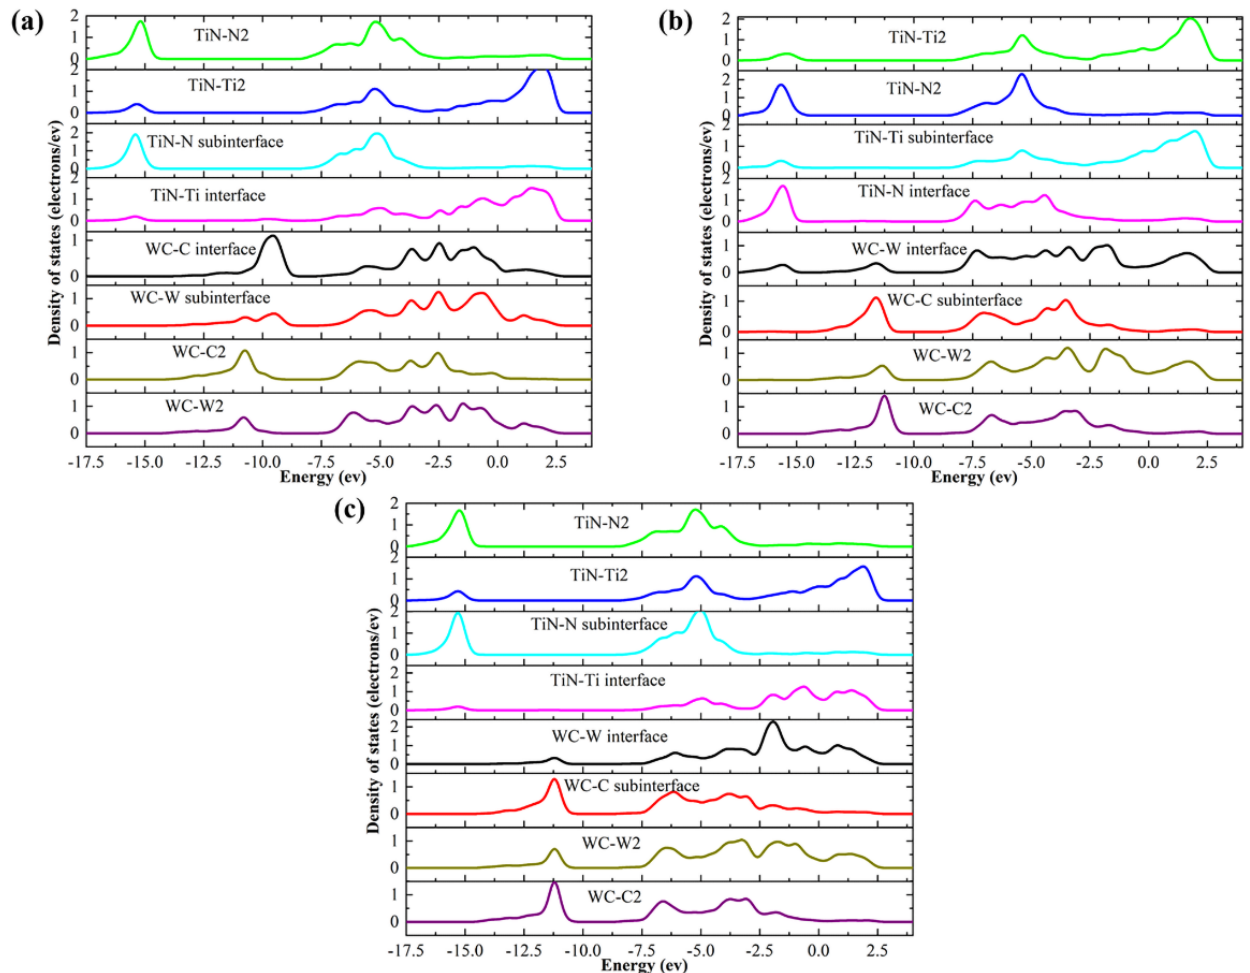
Figure 11. Partial DOS for WC/TiN interfaces: ( a ) C-HCP-Ti, ( b ) W-HCP-N, ( c ) W-Hole-Ti.